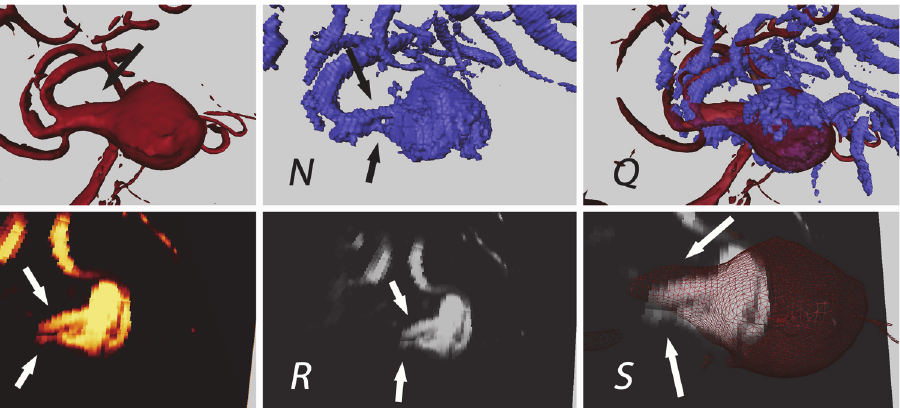
Fig 5. Patient 29: Aneurysm of the medial cerebral artery bifurcation; the black and white arrows indicate the M2 segments of the medial cerebral artery; uncertainty in preoperative rDSA interpretation of M2 segment (single broad vessel vs. 2 nearby vessels); detection of 2 M2 branches (N, P and R) in 3D-ioUS as confirmed intraoperatively; rDSA (red), 3D-ioUS (blue, glow-orange); M: pre-clipping rDSA; N: pre-clipping 3D-ioUS; O: coregistration of M+N; P,Q: MIP of 3D-ioUS; R: coregistration of R+M.